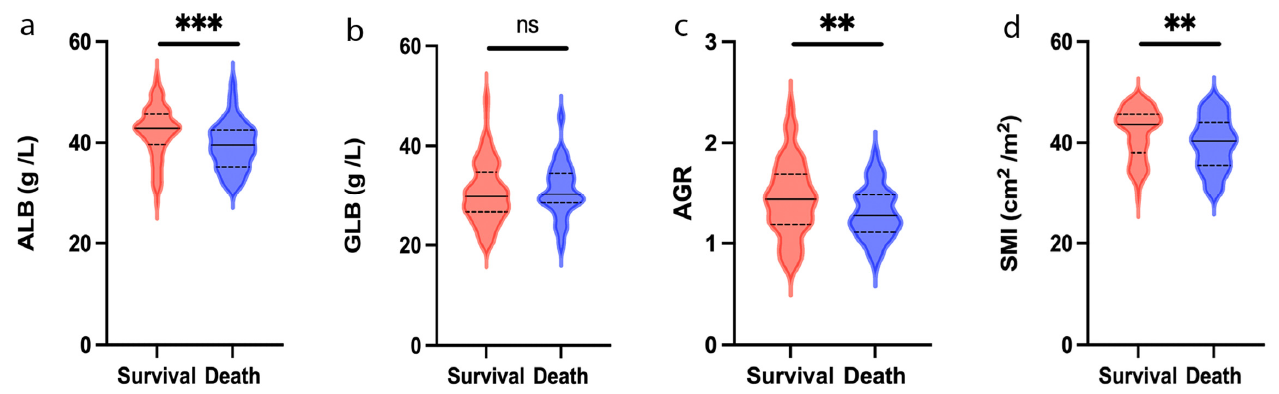
Figure 2. Violin plots showing the preoperative ALB ( a ), GLB ( b ), AGR ( c ), and SMI ( d ) level in survival and death group at the end of follow-up. Solid lines represent the median value; dotted lines represent quartiles. ** p < 0.01; *** p < 0.001; ns, no significance; ALB, albumin; GLB, globulin; AGR, albumin-to-globulin ratio; SMI, skeletal muscle index.